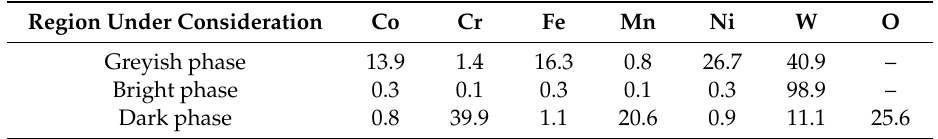
Table 2. The chemical composition of the three di ff erent phases (W, HEA and Cr–Mn-rich oxide phase)